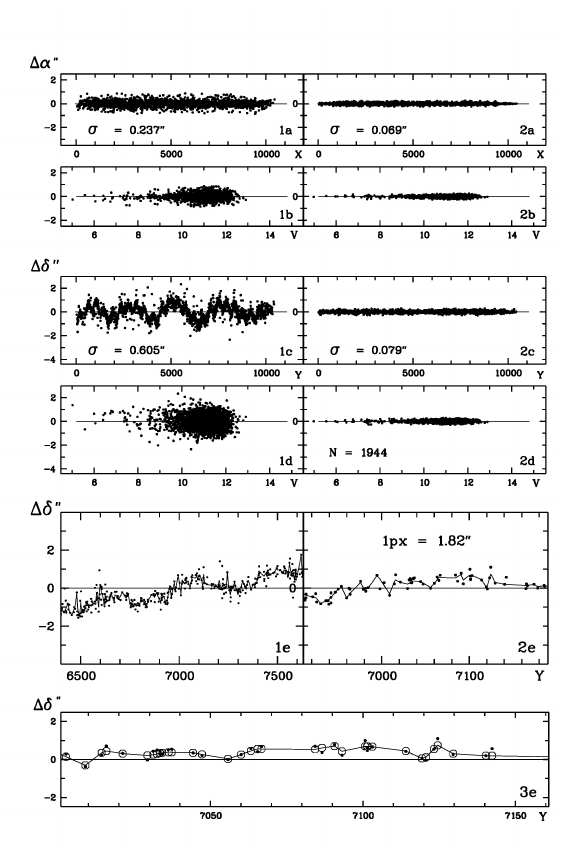
Figure 2. On the four upper panels on the left show the course of scanner systematic errors before correcting for systematic scanner errors, on the right - the values of errors after eliminating scanner systematic errors and telescope optics aberrations. On the three lower panels, the systematic errors of the scanner for the Y coor- dinate are sequentially shown in an enlarged form, the individual deviations for the reference stars correspond to the points, the continuous line and circles (3e) are the result of the approximation of the systematic errors of the scanner.